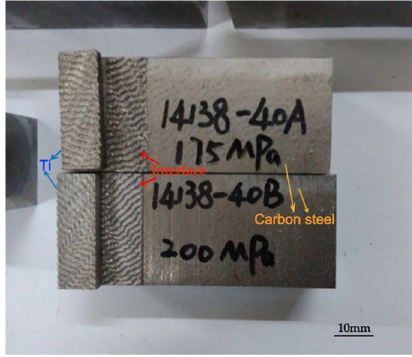
Figure 7. Specimens after shearing test.